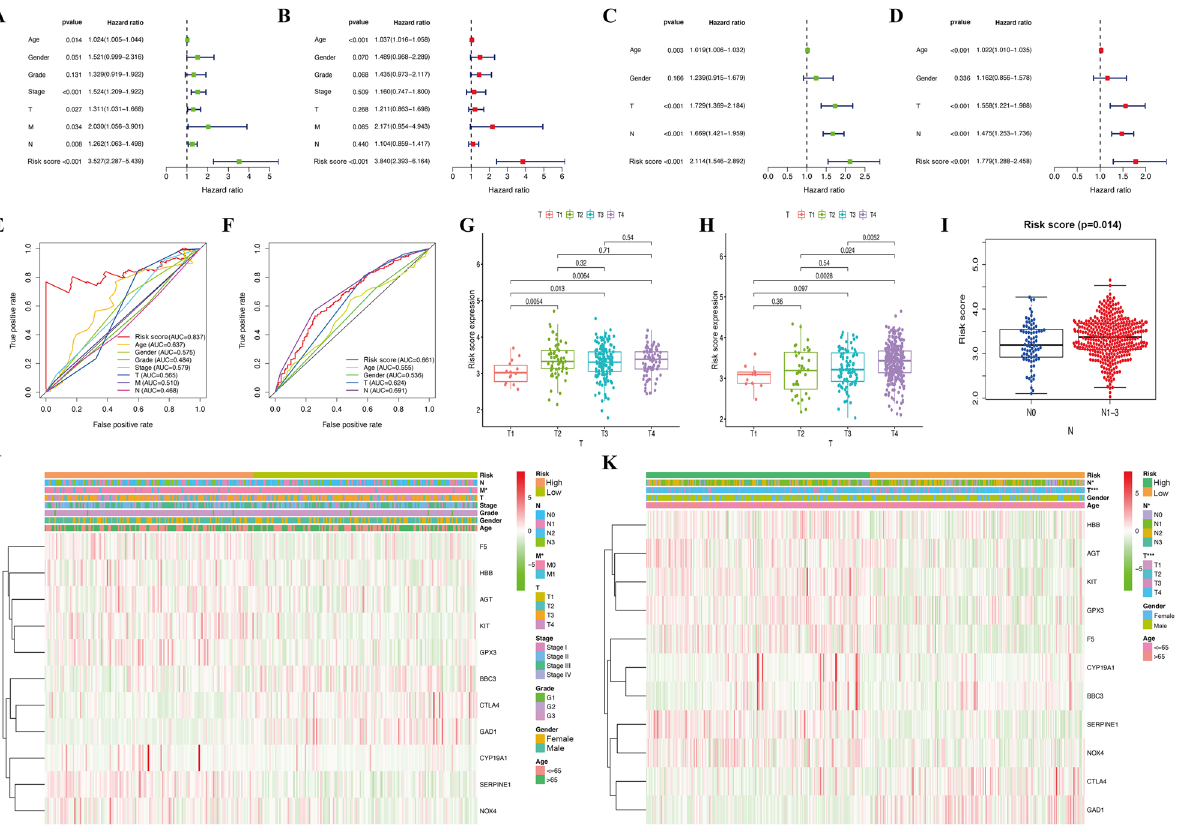
Figure 7. Efficacy evaluation of constructed prognostic model. Univariate ( A ) and multivariate ( B ) Cox regression analysis of the clinicopathological features in TCGA cohort. Univariate ( C ) and multivariate ( D ) Cox regression analysis of the clinicopathological features in GSE84437 cohort. ClinicalROC curves for forecasting overall survival in TCGA ( E ) and GSE84437 ( F ) cohort. ( G ) The relationship between the risk scores and T stage in TCGA cohort. The relationship between the risk scores and T stage ( H ) or N stage ( I ) in GSE84437 cohort. The heatmap shows the distribution of clinicopathological features and OS genes expression in TCGA (J) and GSE84437 ( K ) cohort. Columns in green represent down-regulated genes, columns in red represent up-regulated genes, and columns in white represent unchanged